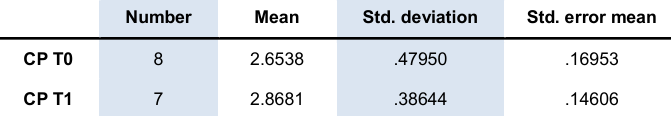
Table 6c: One-sample statistics a − male